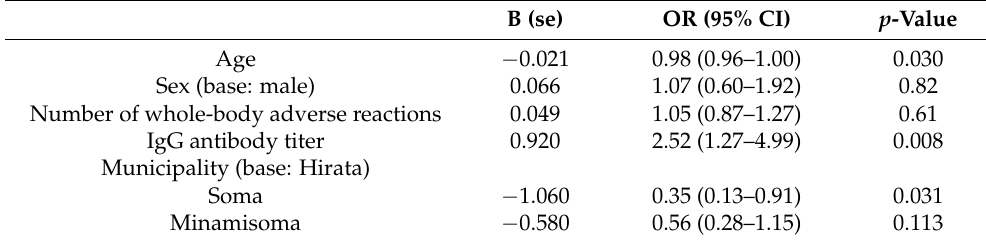
Table 3. Logistic regression analysis to identify the variables influencing vaccine